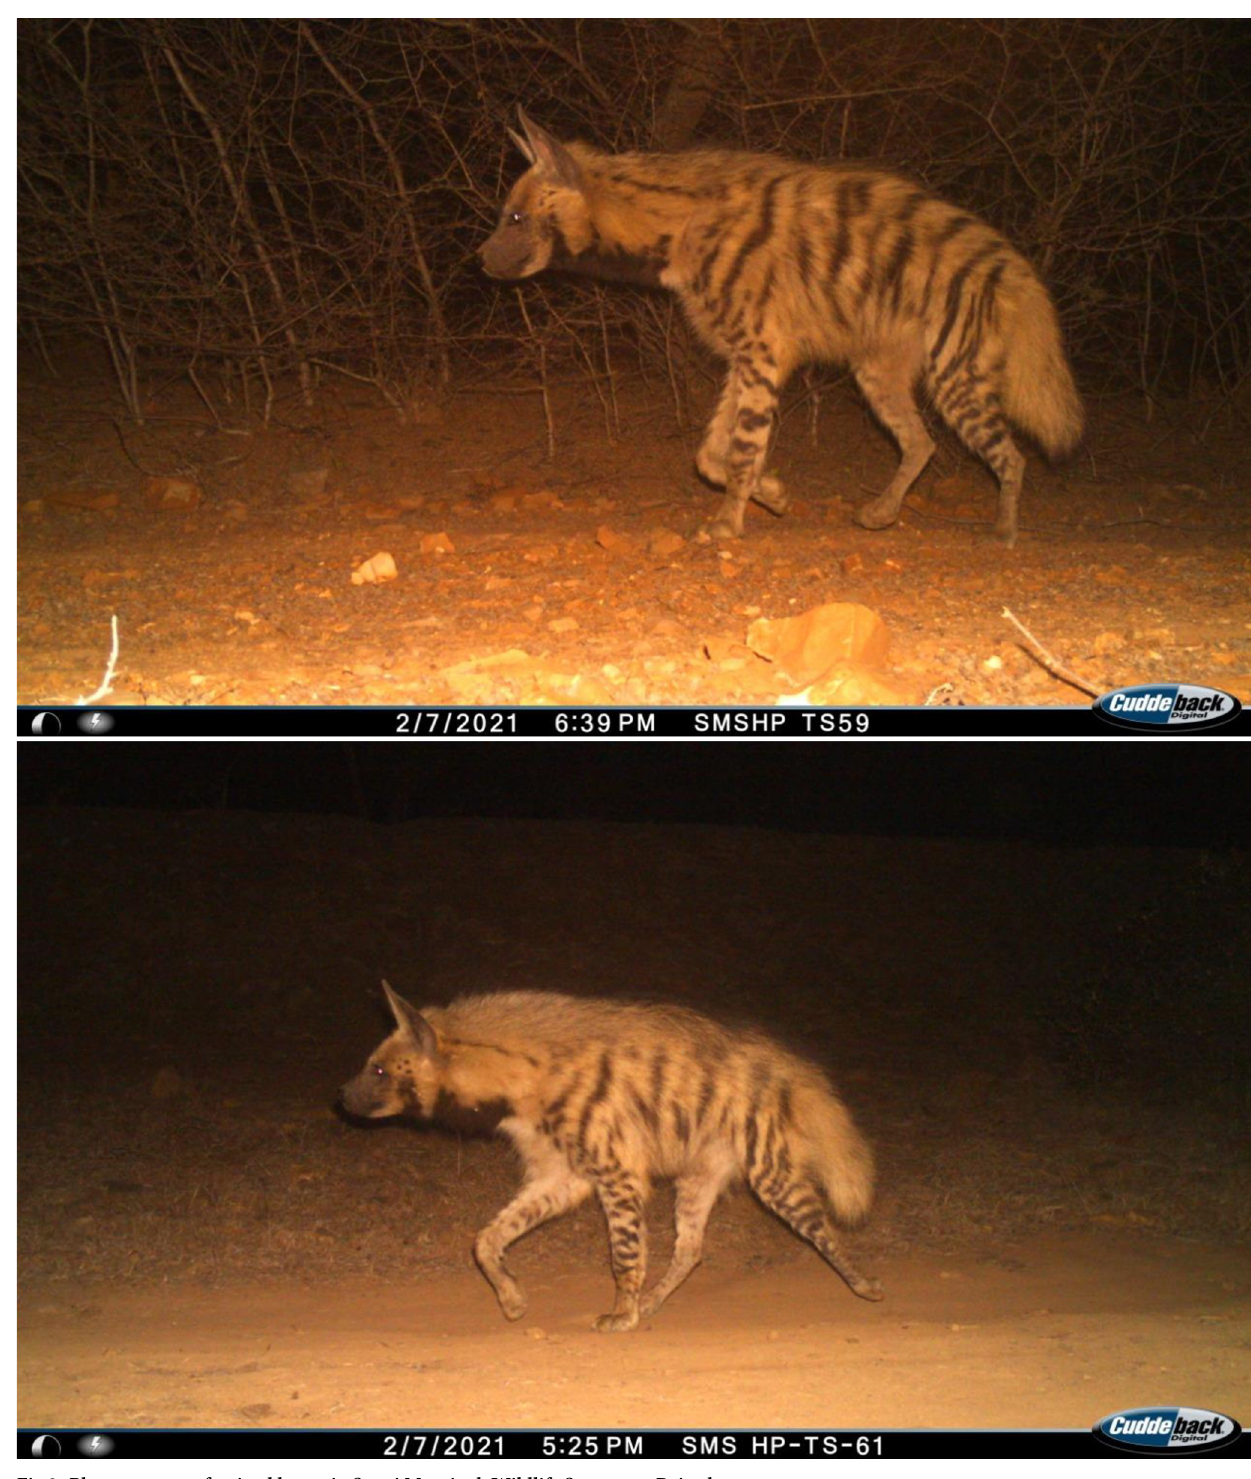
Fig 2. Photo-capture of striped hyena in Sawai Mansingh Wildlife Sanctuary, Rajasthan.